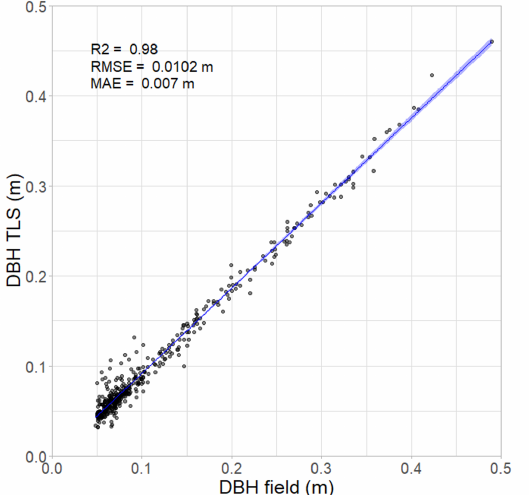
Figure 7. Correlation between field survey and concurrent TLS scan; ribbon showing 95% confidence interval. For every cm increase in TLS DBH there is an average 1.04 cm increase in field DBH (95% CI 1.03–1.05, p < 0.001) ( n =